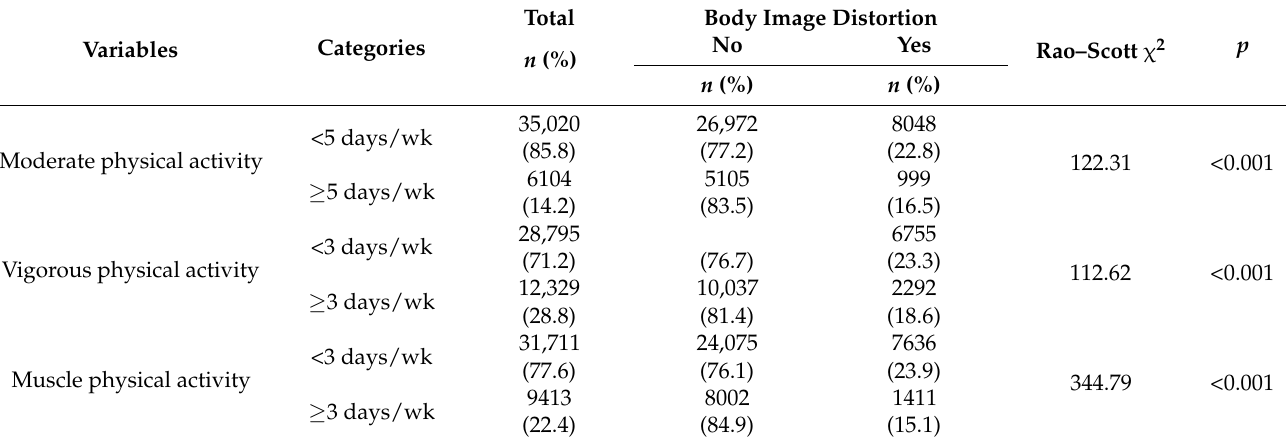
Table 3. Differences in body image distortion by health behaviors ( n = 41,124).